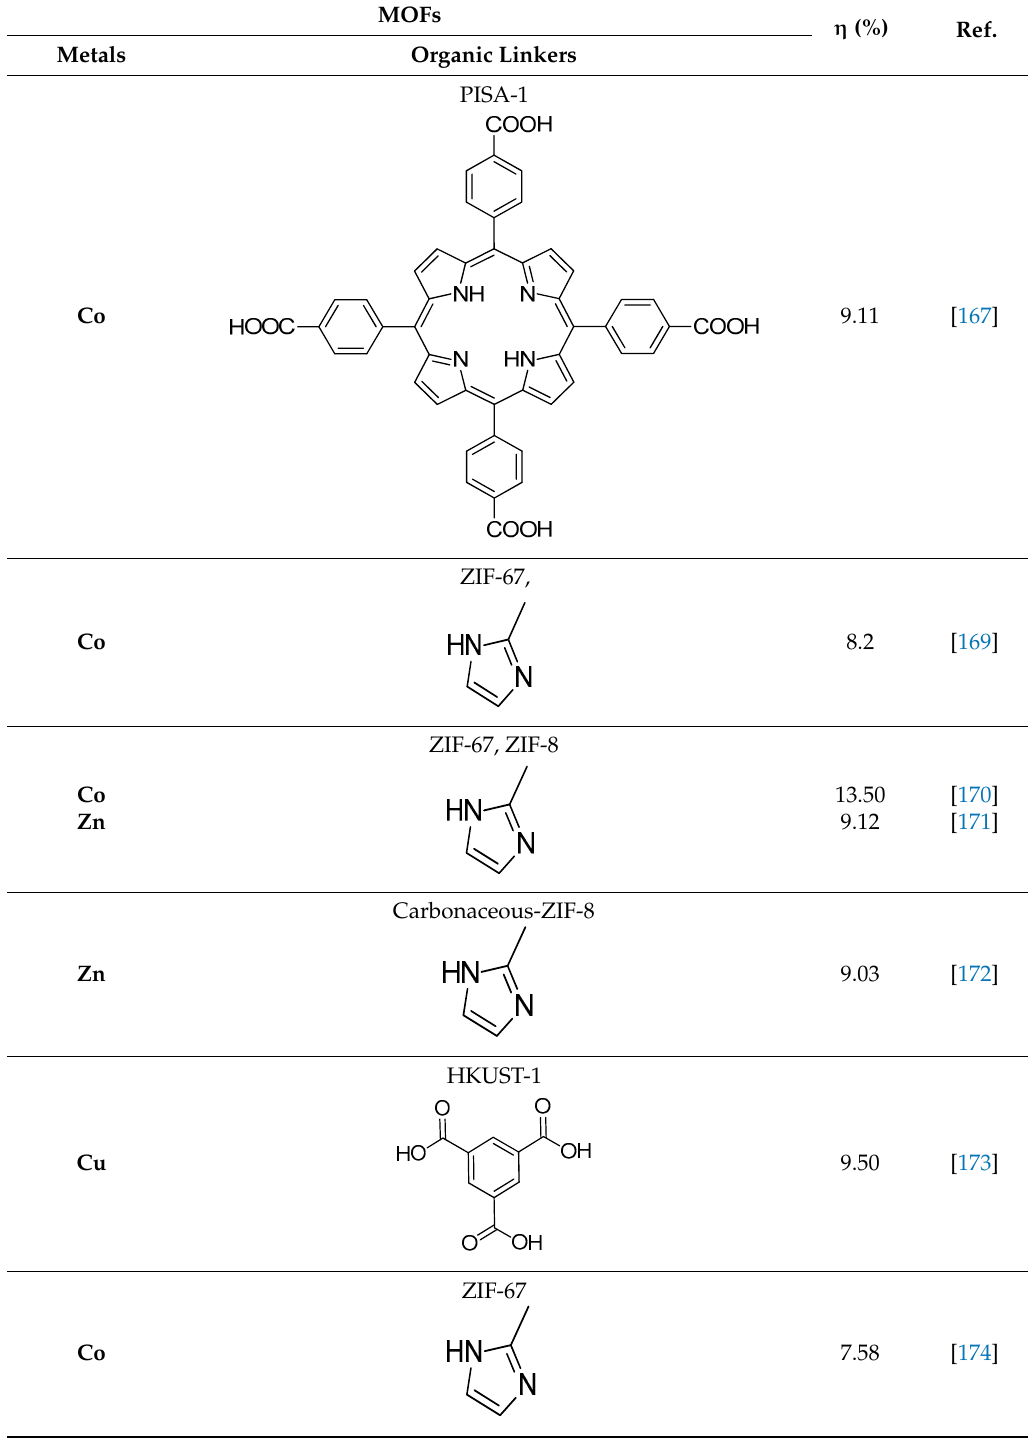
19 of 49 Table 3. MOFs effectively employed as counter ‐ electrodes in DSSC. For sake of brevity, we prefer to report the metal and the organic linker separately. The reported values of photoconversion efficiency could not be compared between each ‐ others, yet they could shine light on the potentiality of this class of material. η (%) Ref.